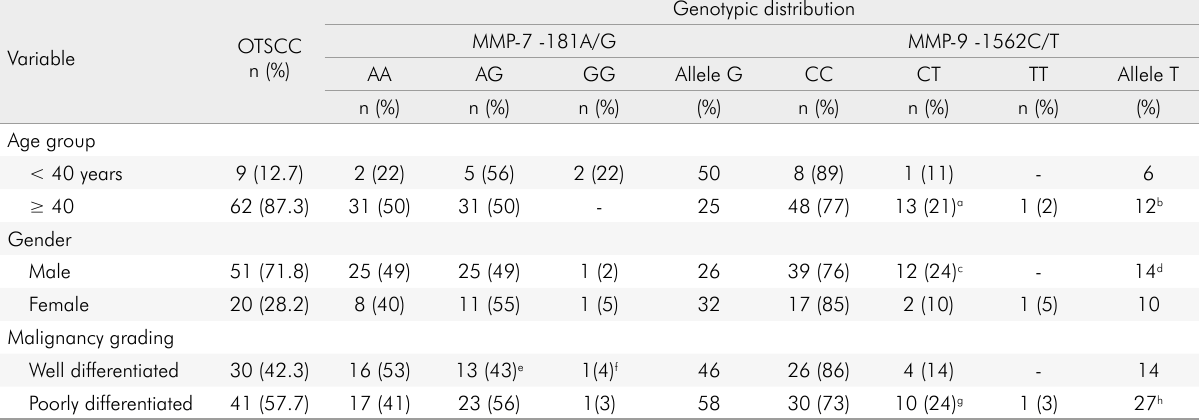
Table 3. Age group, gender, malignancy grading and genotypic distribution of MMP-7 and MMP-9 SNPs in the cases of OTSCC studied.